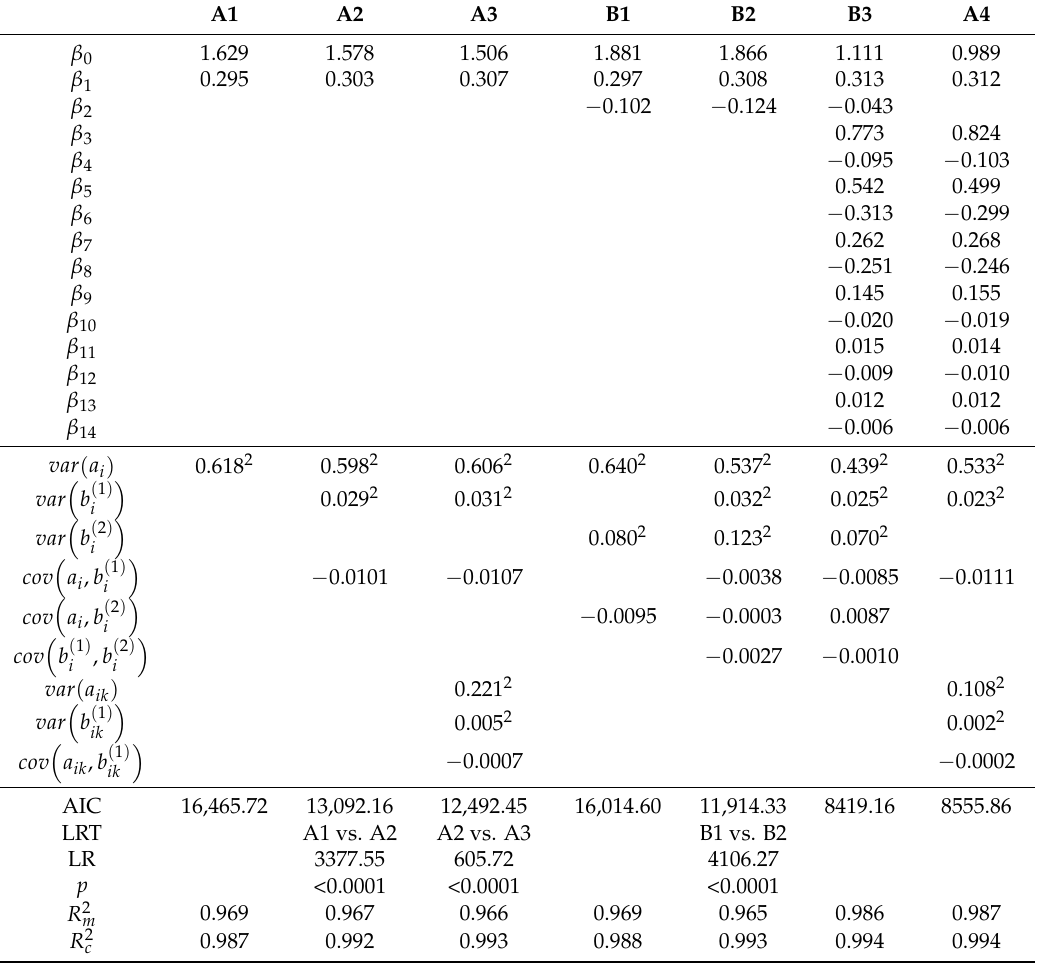
Table 6. Model types. β 0 . . . β 10 are fixed effects; a i , b Akaike information criterion; LRT is the likelihood ratio test with the χ 2 distributed LR (likelihood ratio) and the p -value; R 2 m is the marginal coefficient of determination; and R 2 c is the conditional coefficient of determination. Note that, in contrast to the covariance, the variance is reported as standard deviation